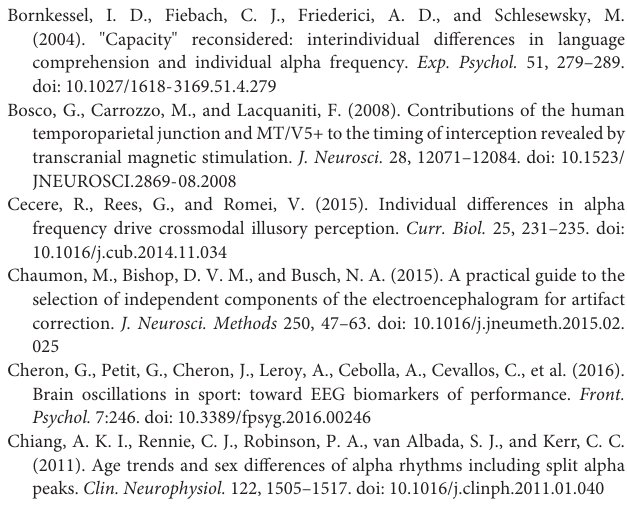
Supplementary Figure 1 | Results of classification comparisons (fast vs. medium vs. slow) for IAF (black line) and VMRT (red/gray line). Classifications are based on behavioral (VMRT) or neurophysiological parameters (N2, N2-r, BA6 negativity latency). Since ANOVA results did not yield a group × region interaction, IAF values reflect the average across all cortical areas of interest. Error bars reflect 95% confidence intervals. n.s. = not significant, ** p < 0.01, *** p < 0.001. Supplementary Table 1 | Group characteristics based on performance classification. Data represent mean ( ± standard